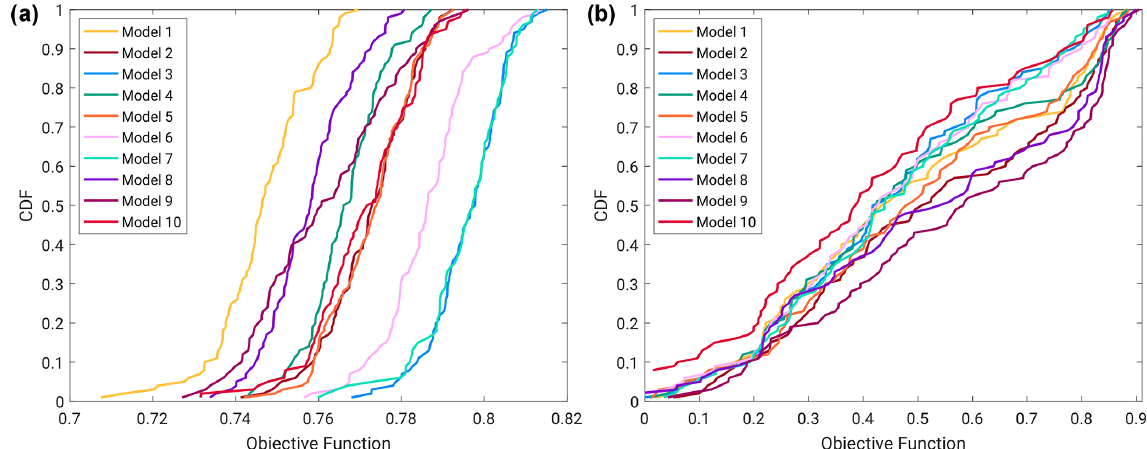
Figure 6. (a) Island Park daily flow calibrated KGE distributions for all 10 models. (b) Altus yearly peak flow calibrated KGE distribution for all 10